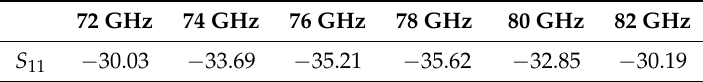
Table 1. Simulated return losses of the V-band power